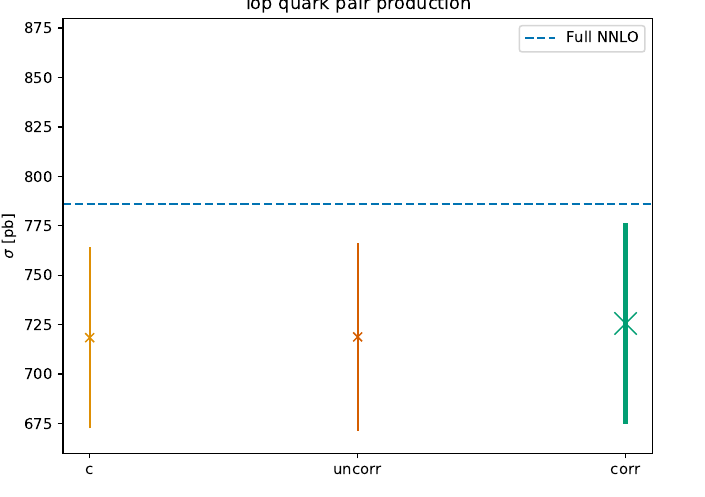
Figure 11 . The same as figure 3 but for the top quark pair production at and setting the central scales to µ 0